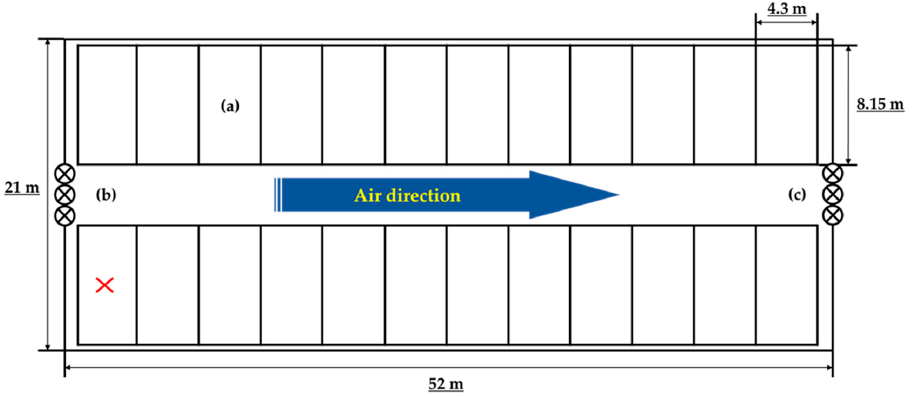
Figure 1. Overview of the cattle barn: ( a ) cattle pen, ( b ) inlet fan, ( c ) outlet fan.